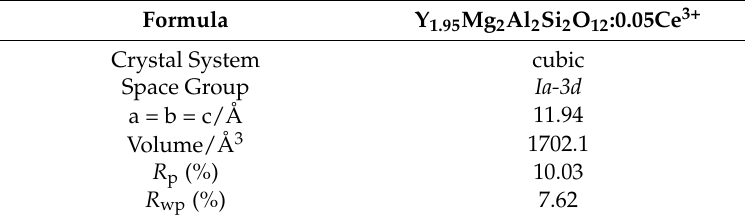
Table 1. Refined crystallographic data and reliability factors for Y 1.95 Mg 2 Al 2 Si 2 O 12 :0.05Ce 3+ .